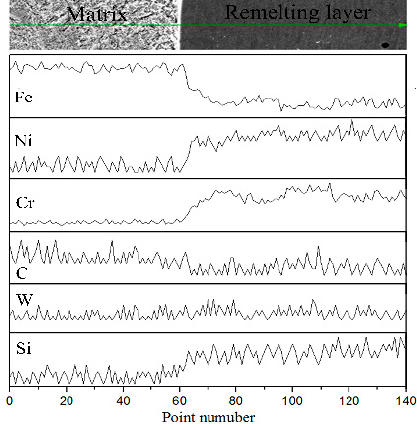
Figure 9. Line scan analysis results at 200 mm/s.